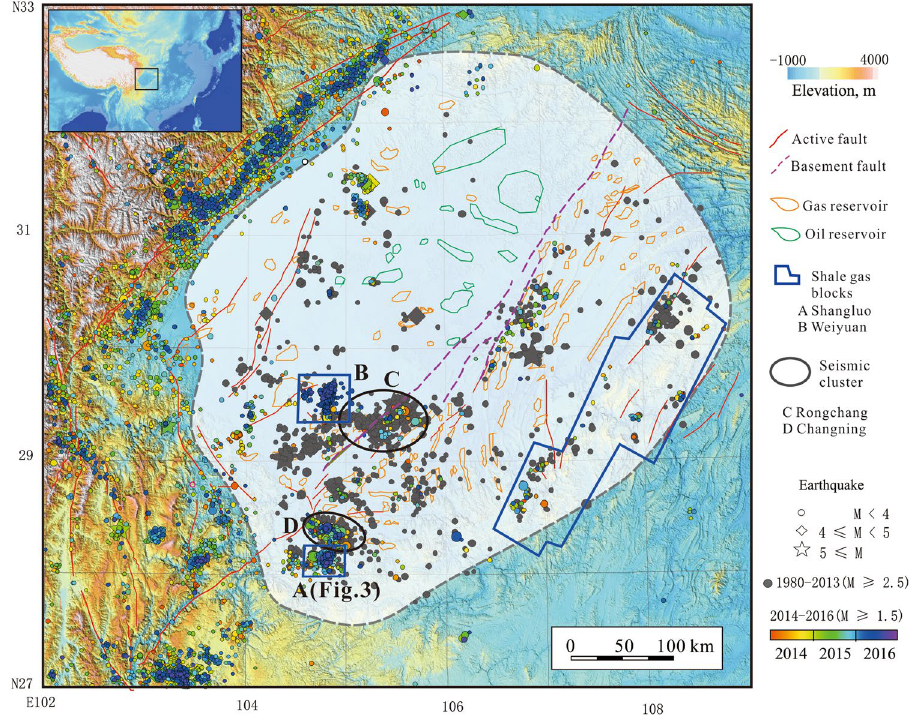
Figure 1. Seismicity of the Sichuan Basin and surrounding regions. The gray and colored dots denote seismic events with magnitudes of at least M L 2.5 and M L 1.5 that have occurred since 1980 and 2014, respectively. Fault data are imported from the digital “Map of active tectonics in China” 52 . The basement faults are hidden deep faults in the crystal basement and show minor activity 53 . The oil and gas field outlines are digitized and modified from an open report 54 . The Shangluo (‘A’, study area of this paper), Weiyuan (‘B’), and other major shale gas blocks in which hydraulic fracturing is in operation are also shown. Area ‘C’ covers the region of wastewater injection induced seismicity in gas-depleted reservoirs 3, 20 , while seismicity in area ‘D’ was induced by water injection in deep salt wells. The background topography is based on the Shuttle Radar Topography Mission (SRTM3) digital elevation model (DEM) data (http://srtm.csi.cgiar.org/SRTM3). The map was created using